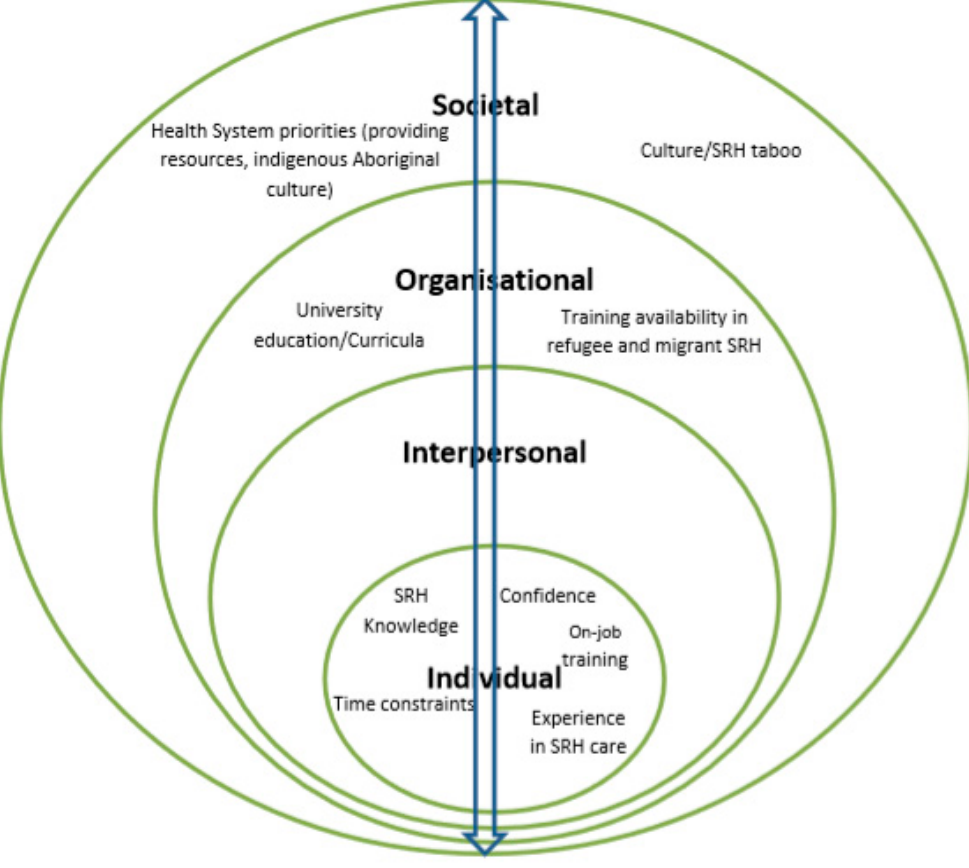
Figure 1. A socio-ecological analysis of factors that influence provider preparedness for delivering SRH care to refugee and migrant women in Australia.